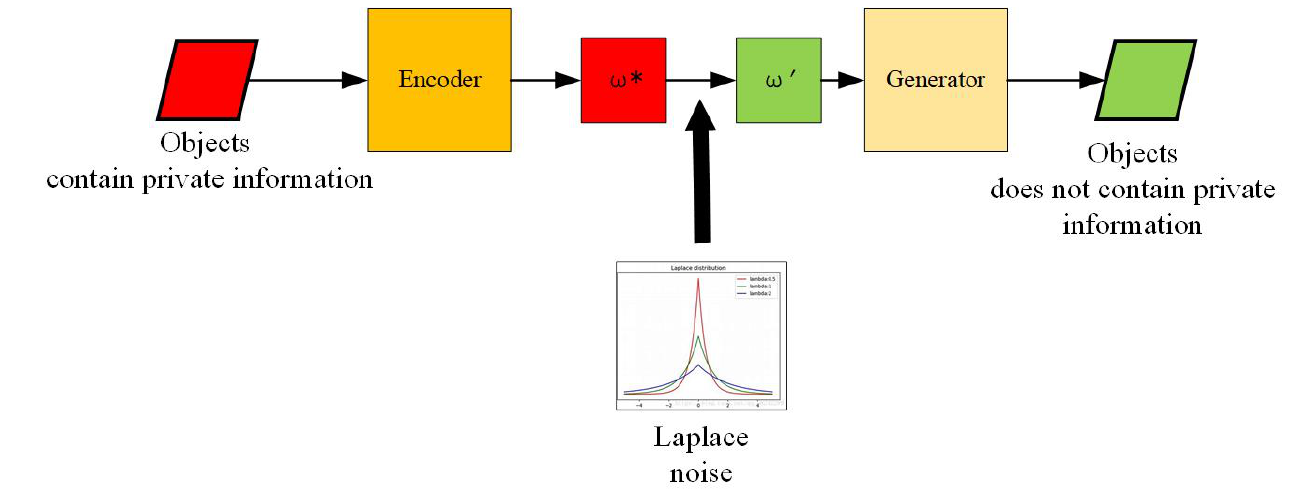
Figure 7. The diagram of de-identification content generation part in our image de-identification (DE-ID)